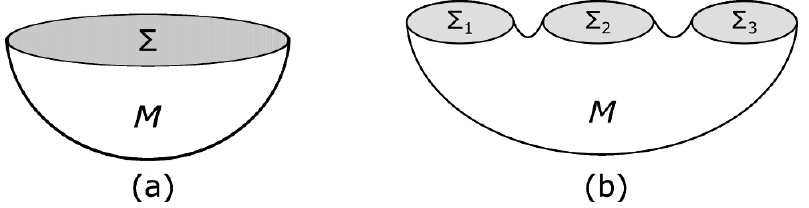
Figure 1 . Figure (a) shows a manifold M having a single boundary (cid:6). Figure (b) shows the manifold M whose boundary has three components, i.e. (cid:6) 1 [ (cid:6) 2 [ (cid:6) 3 .